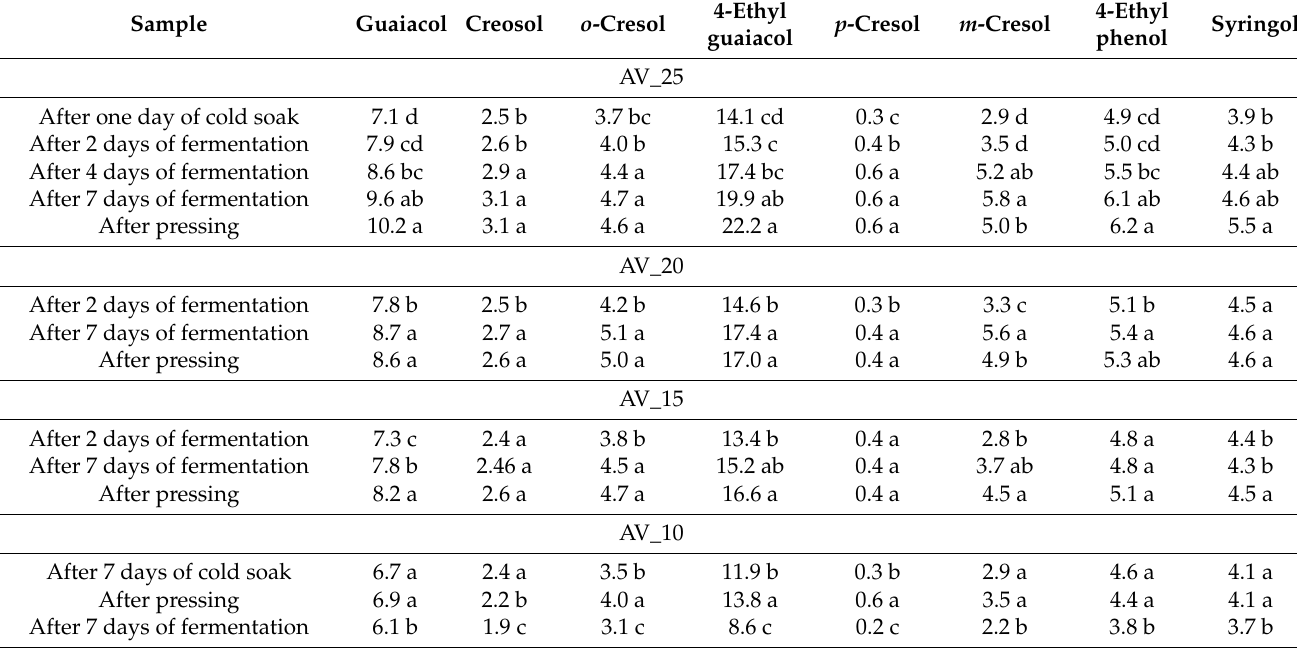
Table 3. Total (free + bound) volatile phenol profiles of samples taken during the winemaking process (n = 3, α ≤ 0.05). All concentrations are in µ